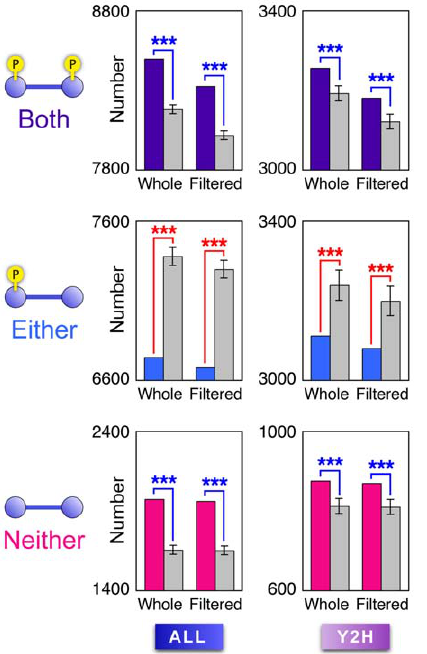
Figure 6. Number counts of interacting protein pairs of each phosphorylation pattern shown in the phospho-PPI network. Respective rows of panels correspond to the three phosphorylation patterns of two interacting proteins: ‘‘Both’’ ( A,B ) ‘‘Either’’ ( C,D ) and ‘‘Neither’’ ( E,F ) respective columns correspond to PPI categories of ‘‘ALL’’ ( A,C,E ) and ‘‘Y2H’’ ( B,D,F ). In each panel, data are shown for two types of phospho-PPI networks: ‘‘whole’’ (i.e. unfiltered) and ‘‘filtered’’ (see text). Colored bars (purple, blue, and pink) represent number counts of protein interactions in real data sets; gray bars show mean values of those estimated by negative controls generated by random edge rewiring (N=10,000). Error bars represent s.d. Blue/red asterisks denote significance of values higher/lower than those of negative controls (*** P , 0.001).